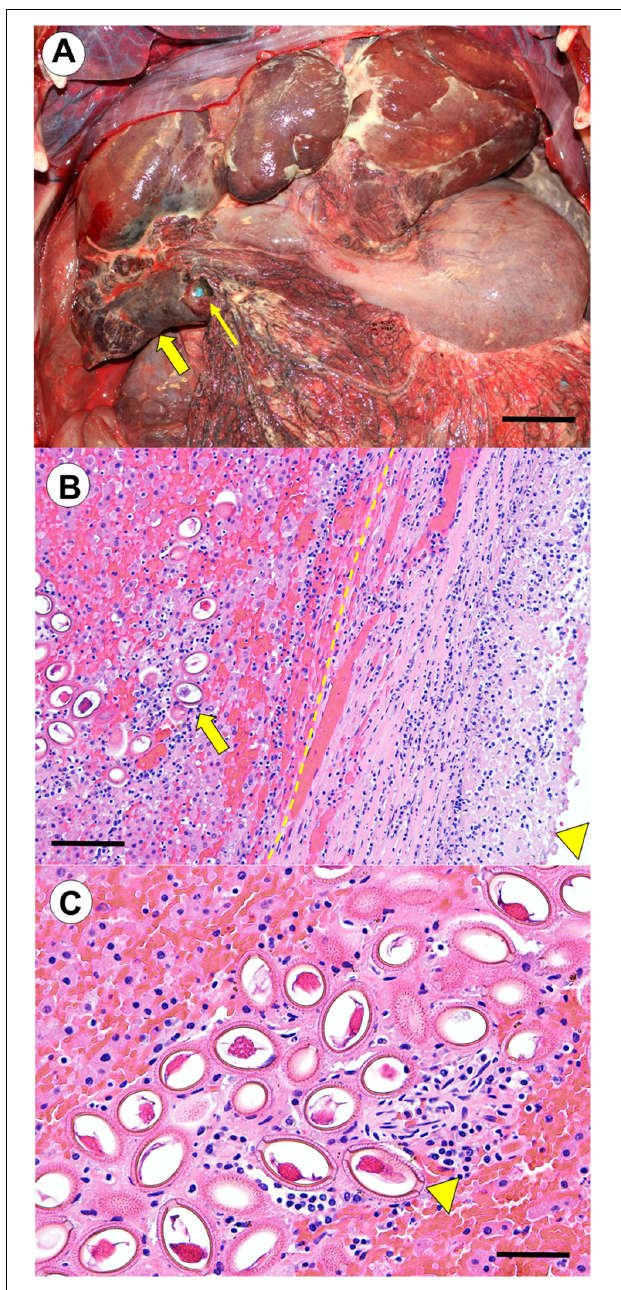
FIGURE 1 | (Case 1): Southern sea otter ( Enhydra lutris nereis ) with chronic, severe hepatic capillariasis due to Capillaria hepatica , with secondary intraperitoneal instrument entrapment in omentum, leading to chronic bacterial omentitis and peritonitis. (A) Cranioventral peritoneum, showing multifocal fibrinosuppurative to fibrous hepatic lobular adhesions, and a severe, focally extensive hepatic-omental adhesion (broad arrow). The firm, adherent omental mass contained an entrapped time-depth recorder (TDR) that had been surgically implanted in the peritoneal cavity during a capture event 3.5 years previously (a blue lateral edge of the entrapped TDR is indicated by the slender arrow). Also visible is severe secondary fibrinopurulent and necrotizing omentitis and peritonitis. Based on findings from histopathology and bacterial culture, the entrapped TDR appears to